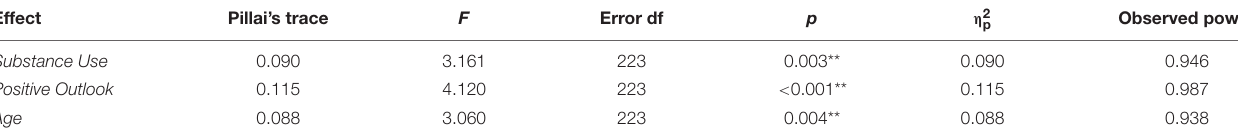
TABLE 7 | MANOVA of predictors of MMR factor scores with non-significant predictors